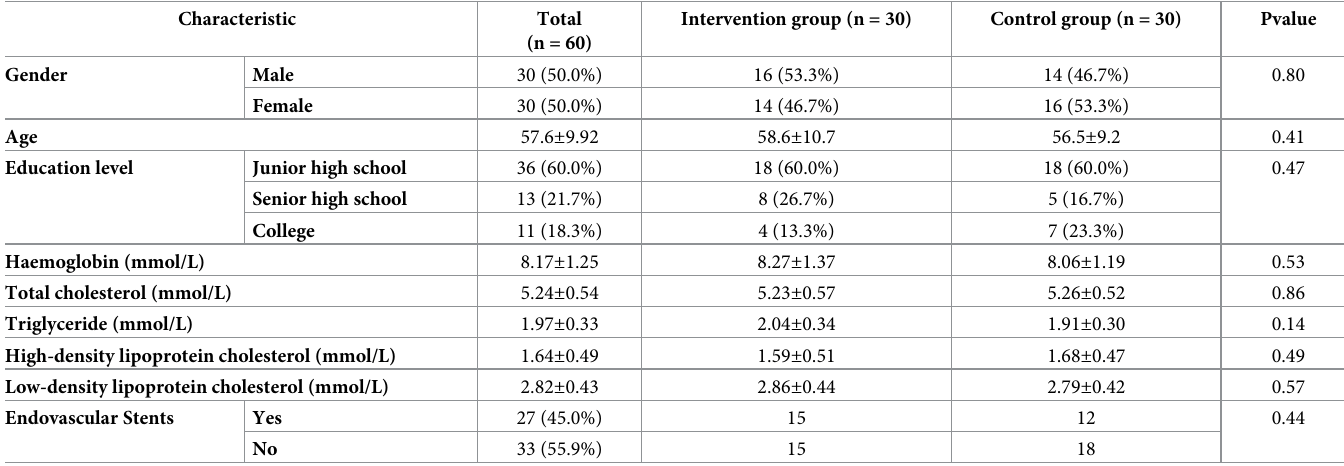
Table 2. Demographic and clinical characteristics of the participants (N =